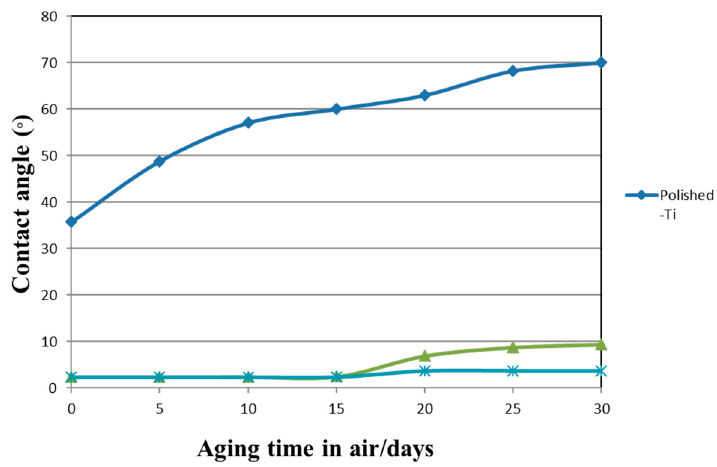
Figure 8. The changes in contact angle of water droplets on Polished ‐ Ti, Ti ‐ AT, and Ti ‐ AT ‐ SPT with aging time are shown. The contact angle for Ti ‐ AT and Ti ‐ AT ‐ SPT was much lower than that for Ti throughout the aging period.